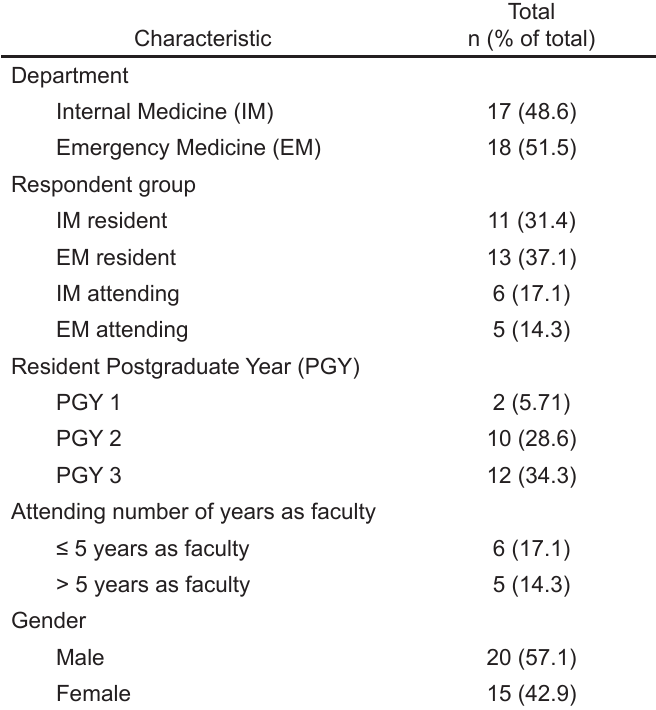
Table 1. Characteristics of focus group participants (n =